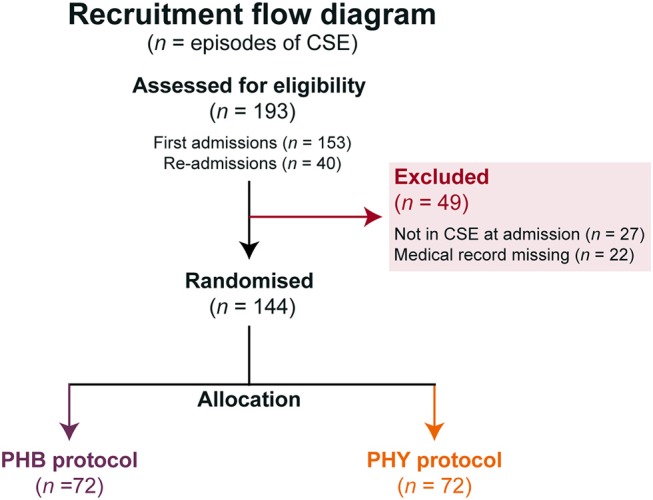
Flow chart of protocol allocation. Number of episodes of pediatric convulsive status epilepticus (n) studied and allocation to the different second-line treatment protocols. All patients allocated a pathway were included in the intention-to-treat analysis. BZP, benzodiazepines (including diazepam, lorazepam and midazolam); CSE, convulsive status epilepticus; PHB, phenobarbital; PHY, phenytoin.